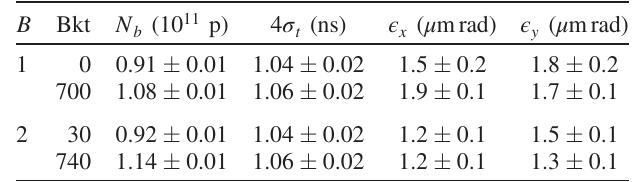
TABLE V. Initial bunch parameters of the four individual bunches in the two beams ( B ) residing in different buckets (Bkt) while performing the experiments with Q 00 .